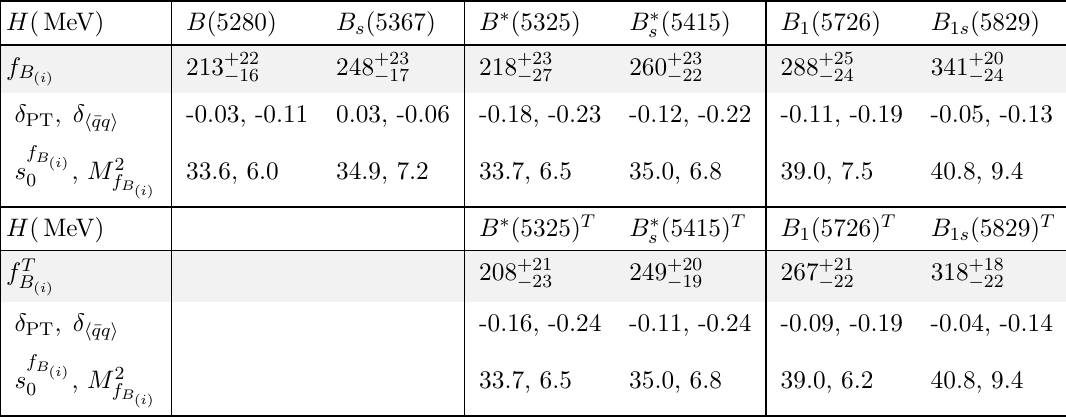
Table 12 . B-meson decay constants, MeV-units, determined in the MS scheme (kinetic scheme values in table 8)) with the Borel parameter and effective threshold given in GeV 2 -units.